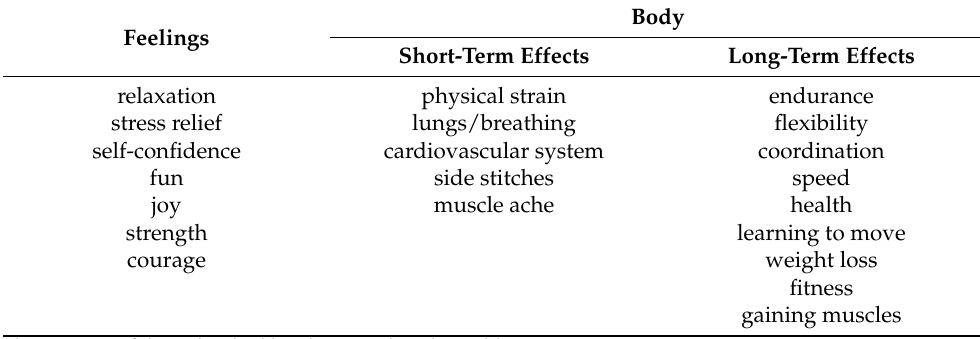
Table 1. Examples of the clusters from the areas of knowledge related to ‘feelings’ and ‘body, long- and short-term (time span)’. Body Feelings Short-Term Effects Long-Term Effects relaxation physical strain endurance stress relief lungs/breathing flexibility self-confidence cardiovascular system coordination fun side stitches speed joy muscle ache health strength learning to move courage weight loss fitness gaining